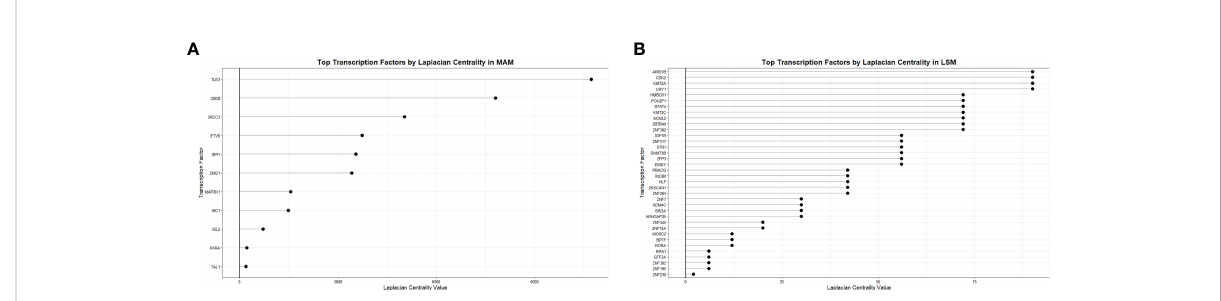
FIGURE 6 Transcription factor centrality in MAM Cell Death and LSM Cell Cycle subnetworks. Dot plots demonstrate signi fi cance of transcription factors regulating the MAM Cell Death (A) and LSM Cell Cycle (B) subnetworks based on Laplacian centrality in descending